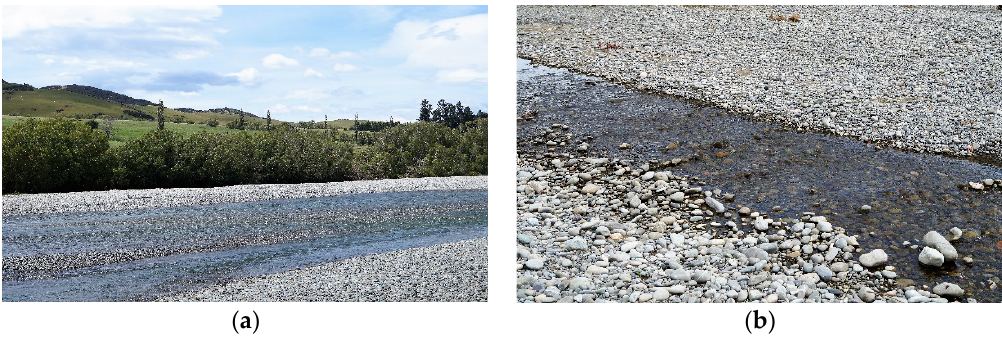
Figure 1. Photograph of a natural gravel-bed stream with a flow direction right to left ( a ); and close view of the natural gravel-bed stream with a flow direction left to right ( b ).